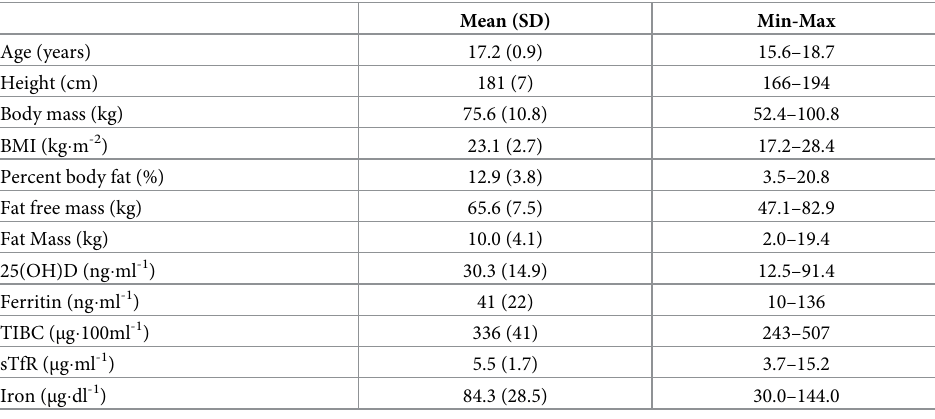
Table 1. Descriptive characteristics for all ice hockey players (n =